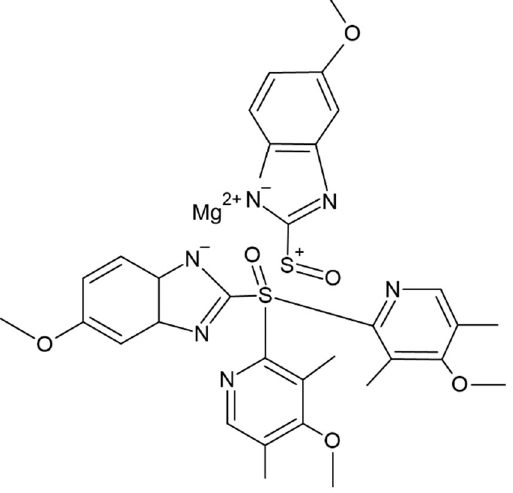
Figure 1. Structural formula of esomeprazole magnesium trihydrate.